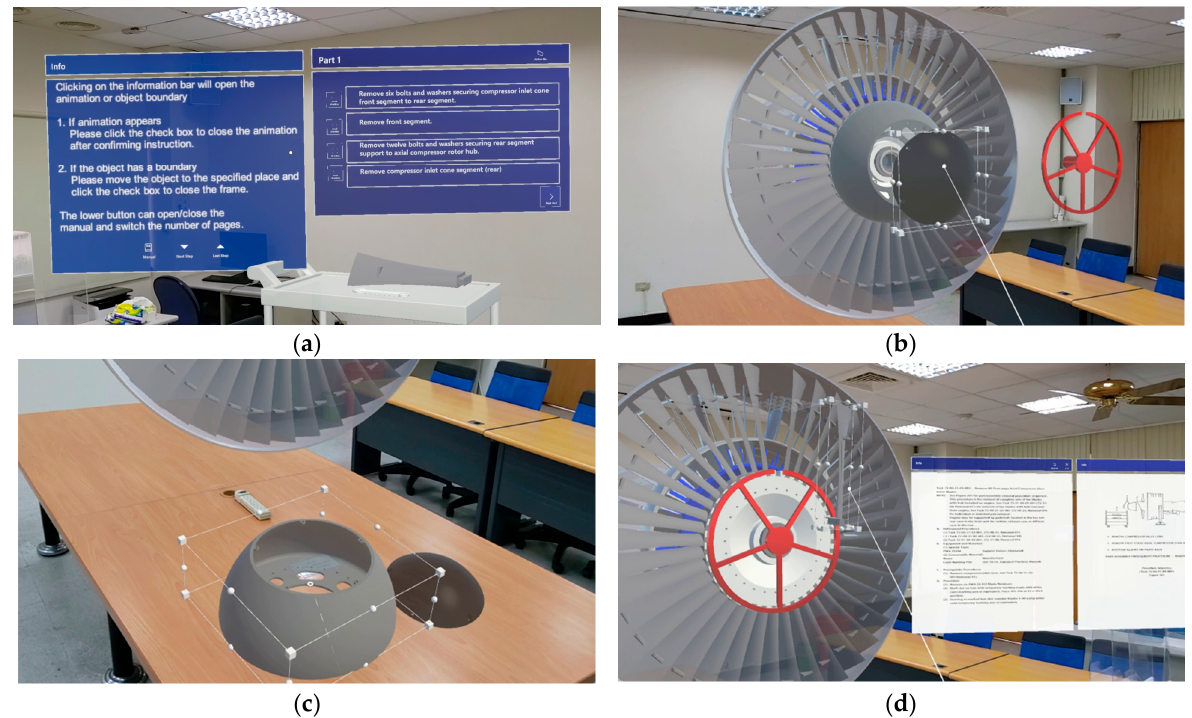
Figure 5. The removal of the engine fan blade scene: ( a ) Procedure of removal fan blades; ( b ) Virtual fan blades; ( c ) Virtual engine cone; ( d ) The ring is placed on front of the engine fan blades.